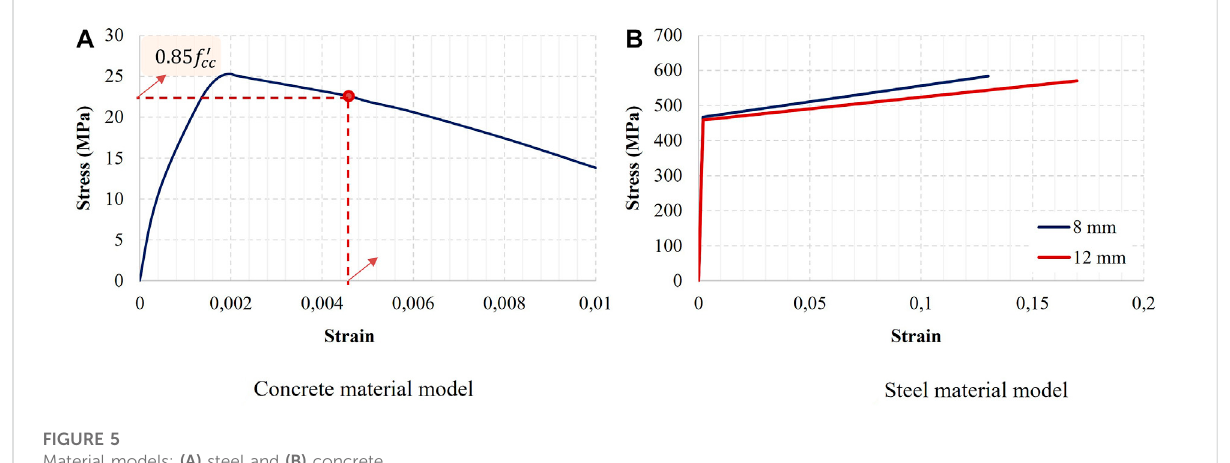
FIGURE 5 Material models: (A) steel and (B)